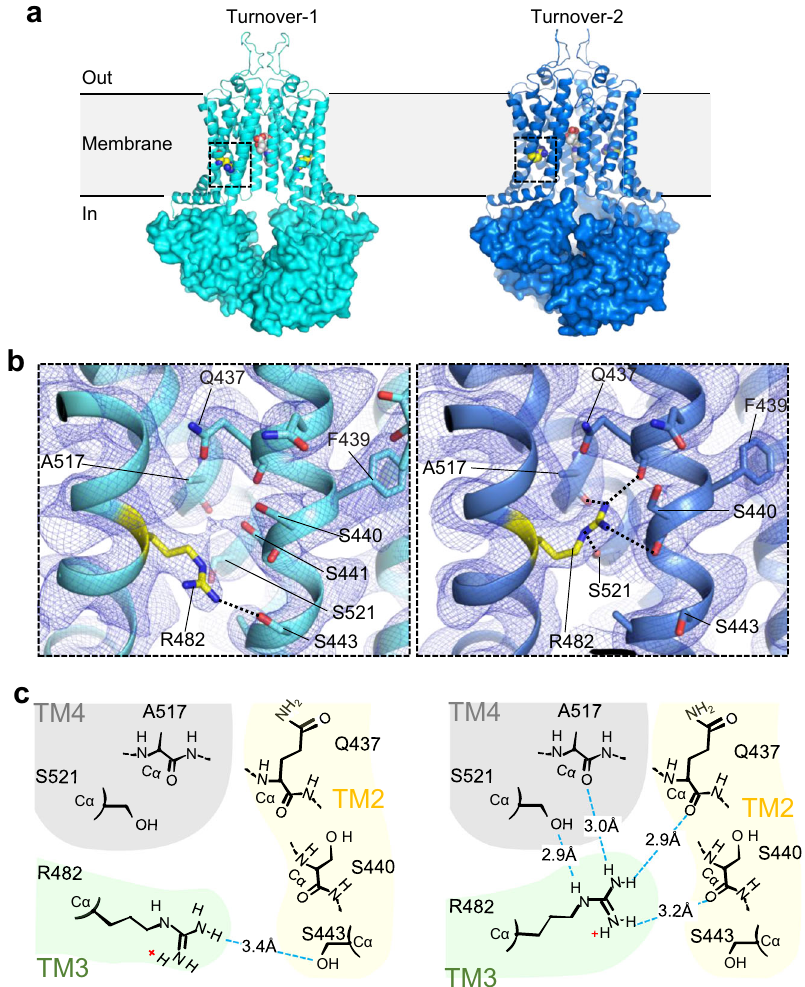
Fig. 4 Conformational change of R482 in turnover states. a Ribbon diagrams of topotecan-bound turnover states, with NBDs shown as surfaces. Bound topotecan and the side chain of R482 are shown as spheres. Dashed black boxes show regions around R482. b Closeup views of TMD regions indicated in a . ABCG2 is shown as a ribbon diagram in turnover-1 (left) and turnover-2 (right) states. R482 and surrounding residues are shown as sticks and labeled. Non-symmetrized EM density is shown as blue mesh. Hydrogen bonds are indicated as black dashed lines. c Schematic diagram of hydrogen bonds formed by R482 in turnover-1 (left) and turnover-2 (right). H-bonds are shown as blue dashed lines. Yellow shading highlights residues of TM2, green shading highlights residues of TM3, gray shading highlights residues of